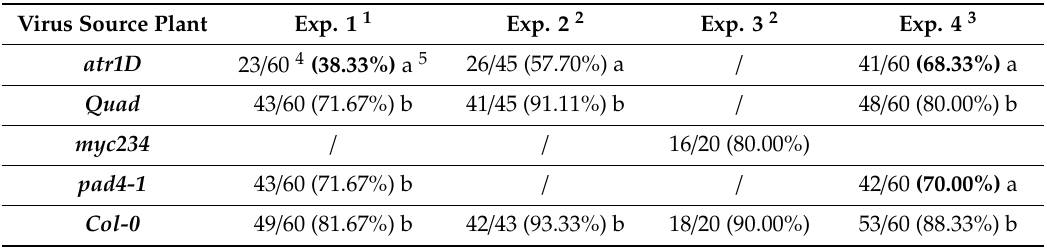
Table2. TuYVtransmissione ffi ciencyfrominfected A.thaliana mutantsatr1D,quad, myc234, andpad4-1. Virus Source